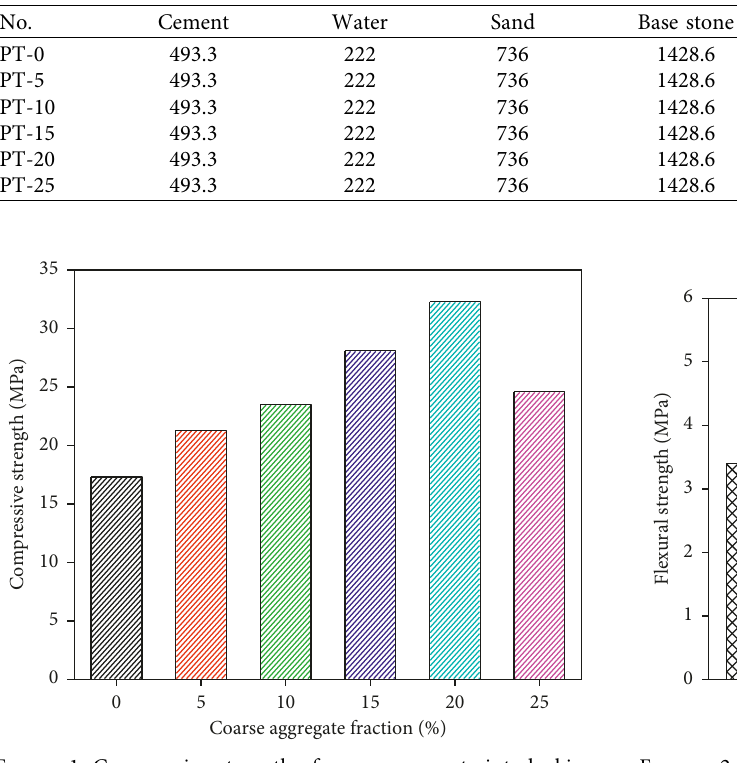
Table 4: Mixing proportions of the coarse aggregate interlocking concrete (kg/m 3 ).